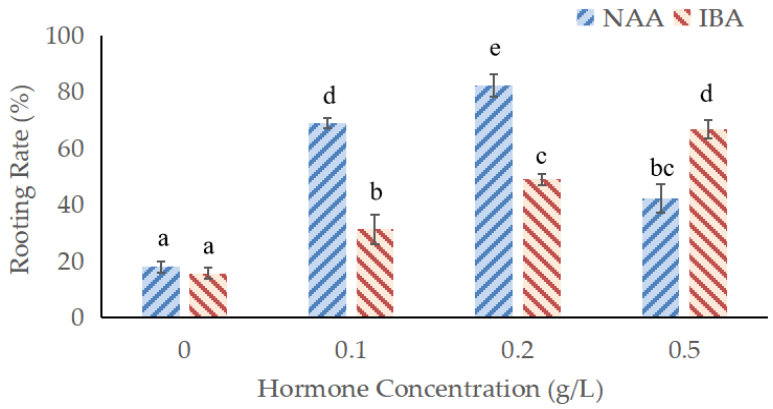
Figure 2. Effects of different plant growth regulator treatments on adventitious shoot rooting of Broussonetia papyrifera . Means with the same letters in the same columns are not significantly different from each other at p ≤ 0.05 (according to Duncan’s multiple range test).